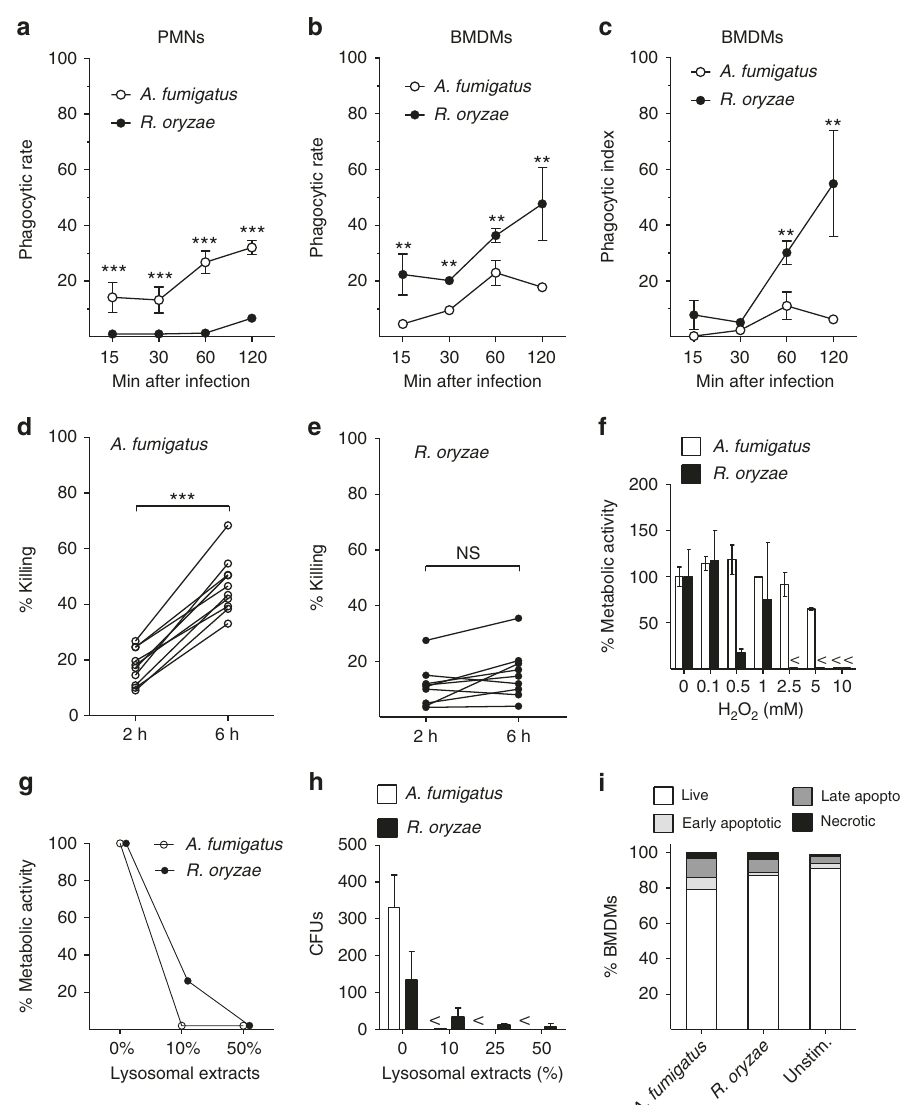
Fig. 2 Rhizopus conidia display resistance to ex vivo killing by macrophages. a – c Comparative studies on phagocytosis of A. fumigatus and R. oryzae conidia by BMDMs and neutrophils (PMNs) assessed by confocal imaging. Data on quanti fi cation of phagocytosis are presented as mean ± SEM of fi ve independent experiments *** P < 0.0001, ** P < 0.001, Mann – Whitney test. d , e Intracellular killing of A. fumigatus and R. oryzae (Mucorales) conidia by BMDMs. Symbols connected with a line represent time points of the same independent experiment ( n = 9 per group). *** P < 0.0001, Mann – Whitney test. f , g Assessment of in vitro susceptibility of A. fumigatus and R. oryzae conidia to f oxidative damage induced by increasing concentrations of H 2 O 2 or g to damage induced by enzymatic activity of increasing concentrations of lysosomal extracts of BMDMs, assessed by measurement of fungal metabolic activity using the XTT assay at 24 h. h In vitro fungicidal activity of increasing concentrations of lysosomal extracts against conidia of A. fumigatus or R. oryzae assessed by CFU plating. i Induction of apoptosis in unstimulated BMDMs or BMDMs infected with A. fumigatus or R. oryzae at an MOI of 3:1 (effector:fungal cells) for 6 h. Apoptotic BMDMs were assessed by FACS analysis following Annexin V/PI staining. Data are representative of one out of three independent experiments. NS not signi fi